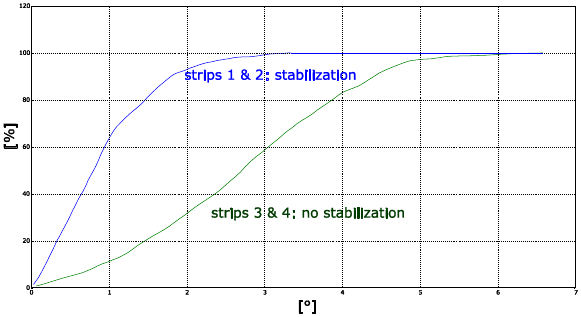
Figure 10. Empirical cumulative distribution function for pitch values. Flight